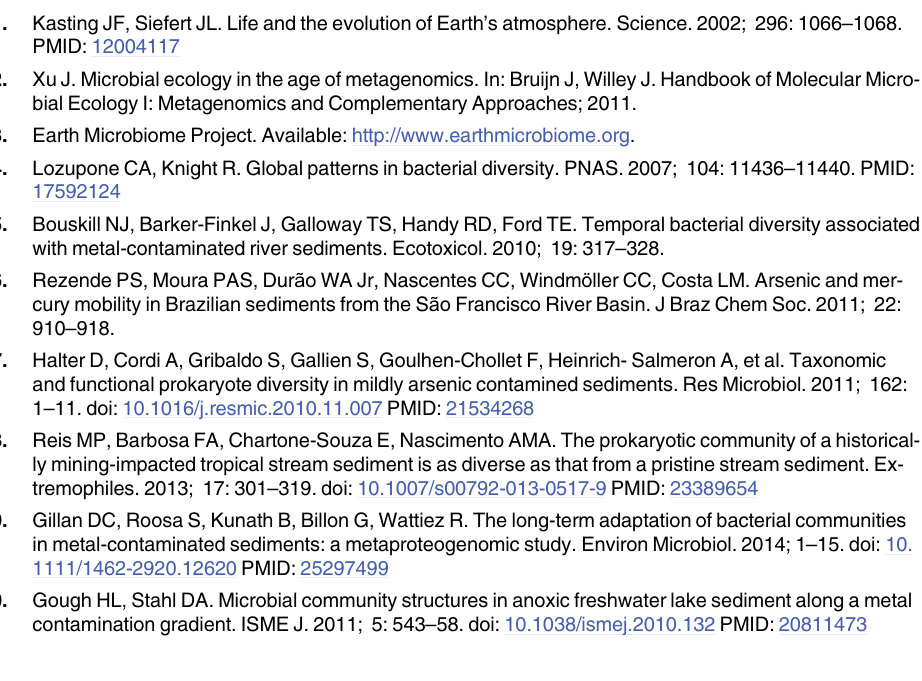
S3 Fig. The bacterial (A and B) and archaeal (C and D) standard curves (A). (TIF) values from the 16S rRNA gene amplifications. A and B represent bacterial S4 Fig. The C t and archaeal amplifications, respectively. S5 Fig. Nitrogen cycle representation obtained in the Keeg Mapper analysis of MG RAST web server based on SEED database. The red square represents the presence of enzyme se- quence in the MSS metagenome. S1 Table. Taxonomic affiliation of 16S rRNA gene OTUs based on Greengenes database. S2 Table. Carbon sources utilization by microbial communities in aerobic and anaerobic condition and diversity index in sediment of the Mina